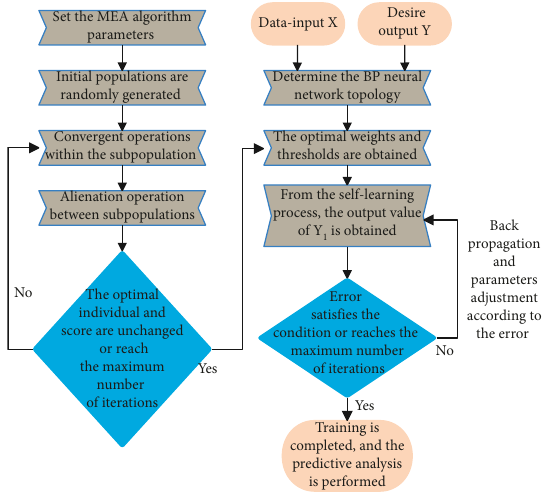
Figure 6: MEA to optimize BP neural network